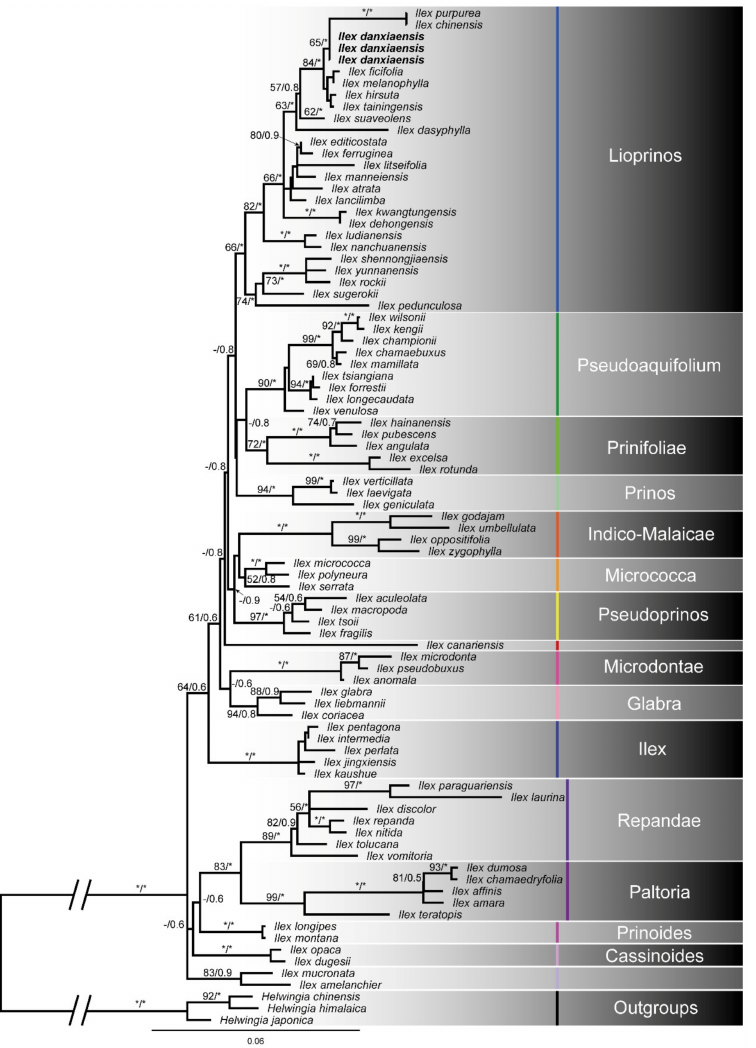
Figure 5. Maximum likelihood (ML) tree of genus Ilex from phylogenetic analysis of combined ITS, ETS, and nepGS sequence data. Numbers near each branch are maximum‑likelihood bootstrap sup‑ port (MLBS) and Bayesian inference posterior probability (BIPP). Dash means that MLBS ≤ 50% or BIPP ≤ 0.5. “*” means that MLBS =100% or BIPP=1.0. The new species Ilex danxiaensis is indicated in bold in the ML